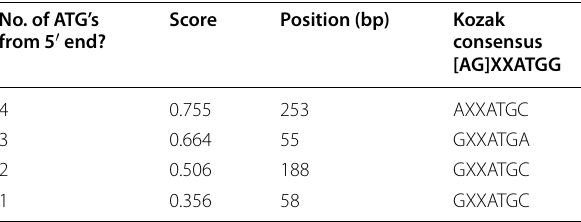
Table 3 Prediction of start codon, score, position, and Kozak consensus sequence by DNA TIS miner No. of ATG’s from 5 ′ end?